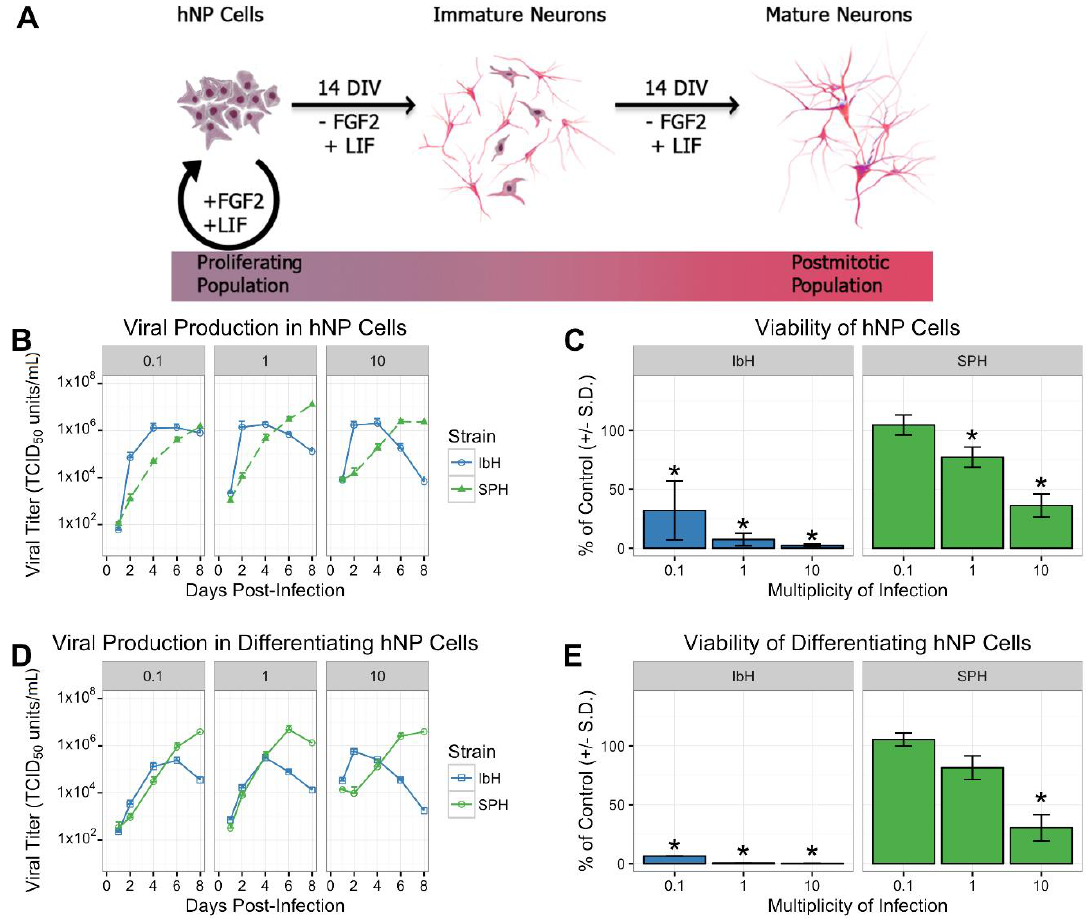
Figure 1. Zika virus (ZIKV) isolate-specific growth and cytotoxicity in human pluripotent stem cell-derived neural progenitor (hNP) cells at six days post-infection. ( A ) hNP cells are maintained as a proliferating population in media with fibroblast growth factor (FGF) and leukemia inhibitory factor (LIF). Withdrawal of FGF and LIF from the media leads to differentiation and a population of immature neurons after 14 DIV, then post-mitotic neurons exclusively emerge after 28 DIV. ( B – E ) African-lineage ZIKV isolate (IbH) grew robustly and induced cell death in undifferentiated hNP cells and differentiating hNP cells, while Asian isolate (SPH) replicated more slowly with less extensive cell death. * demonstrates p < 0.05.